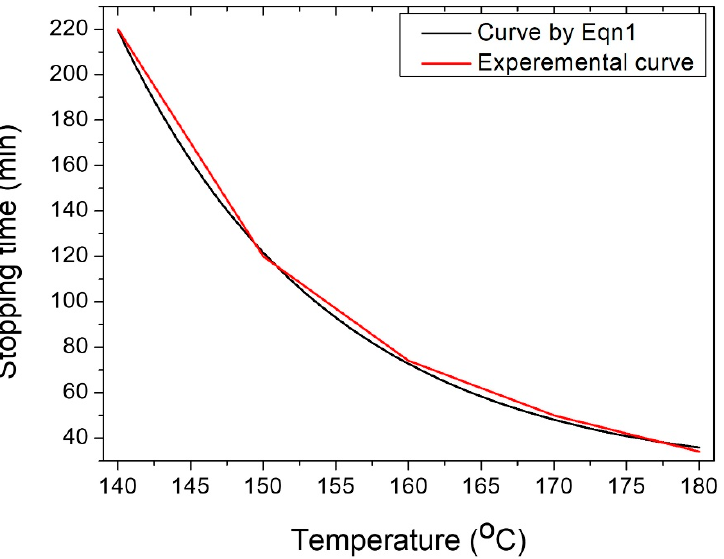
Figure 4. Experimental growth time against growth temperature of AgNWs in the suspension (red) fitted to the theory (black).